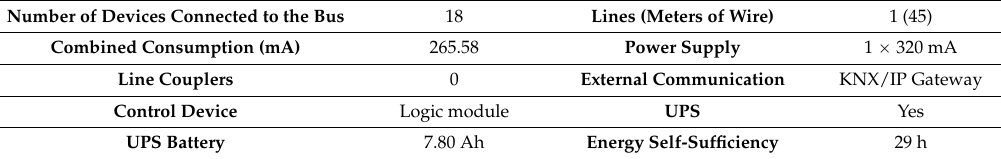
Table 10. General features of advanced home automation system.